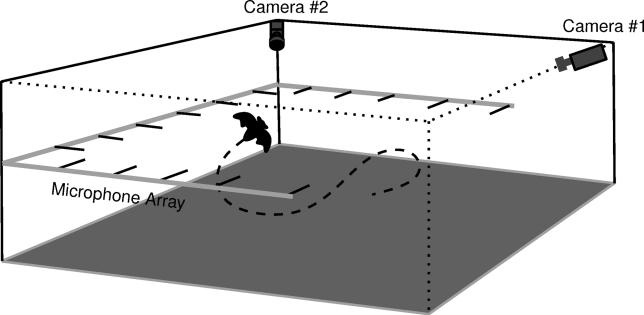
Instrumented Flight RoomThe bats were trained to fly in a flight room 7.3 m × 6.4 m × 2.5m high. The room walls and ceiling were covered with sound-absorbent foam to reduce reverberations. Illumination was dim red lighting (wavelength >650 nm) to exclude the bat's use of vision. Two digital video cameras operating at 240 frames/s recorded the bats and tethered insects during the experiments.